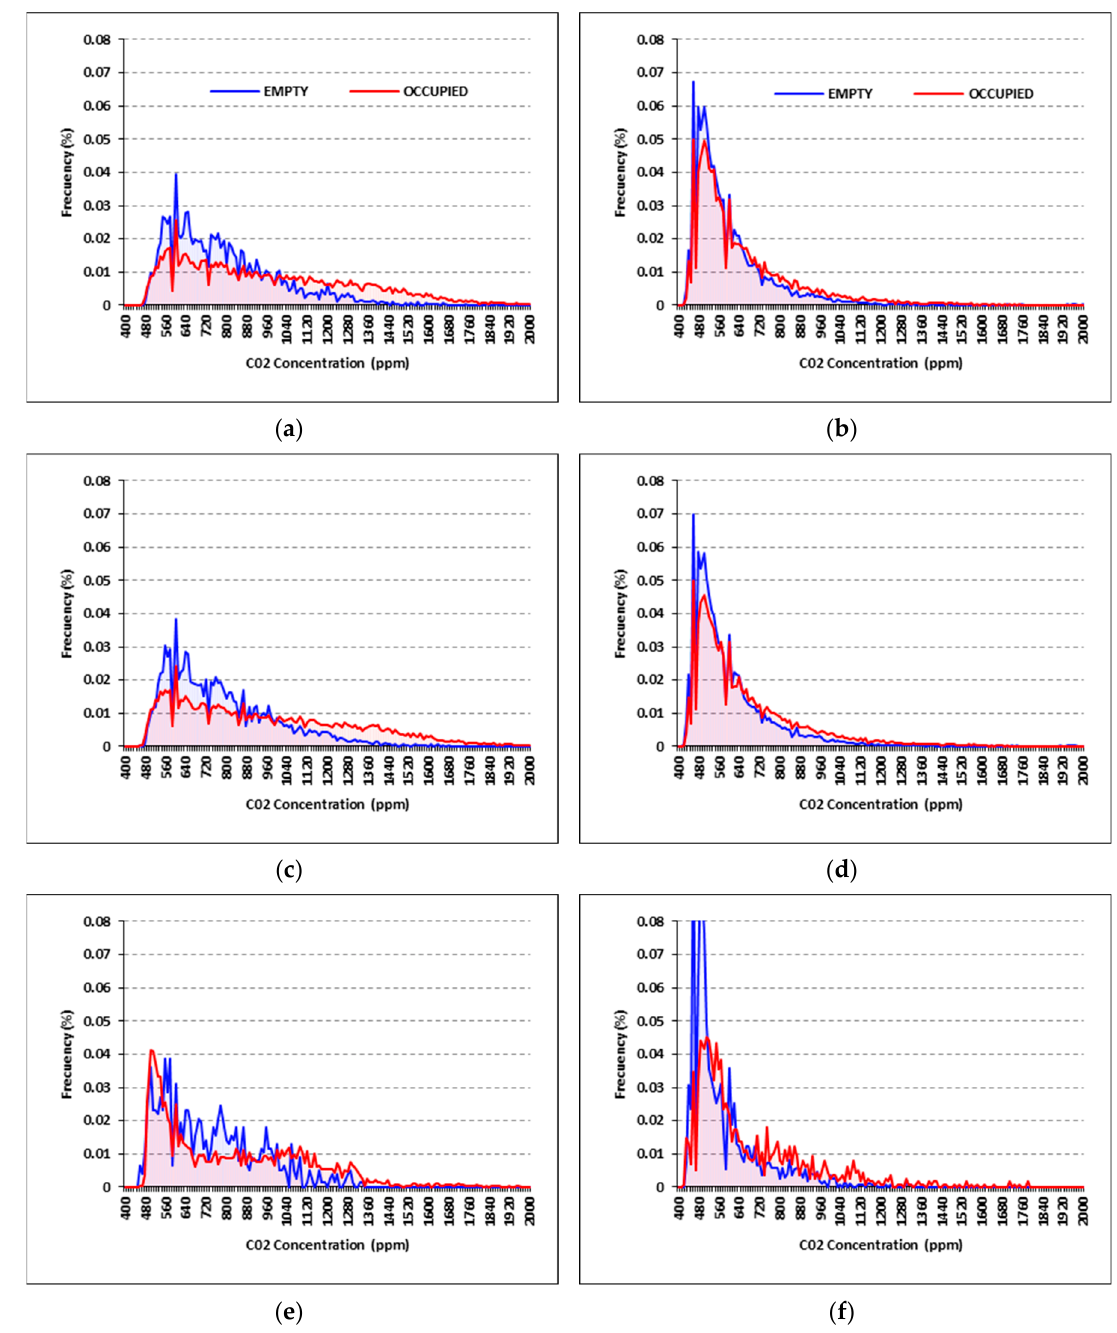
Figure 8. Histogram of CO 2 considering that the building is empty if electricity consumption is below 120 W, and occupied if it is above 120 W. From these figures 1000 ppm and 640 ppm have been identified as the breakpoints for winter and summer, respectively. The analysis distinguished between summer and winter and the di ff erent working levels of the mechanical ventilation system. CO 2 intervals every 2 ppm: ( a ) winter level 0; ( b ) summer level 0; ( c ) winter level 1; ( d ) summer level 1; ( e ) winter level 2; ( f ) summer level 2.